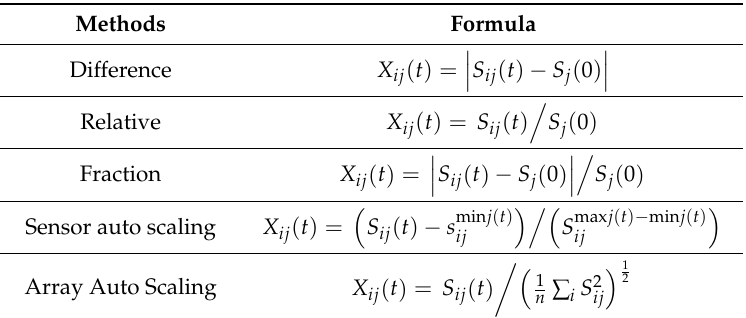
Table 3. Methods of data preprocessing for baseline